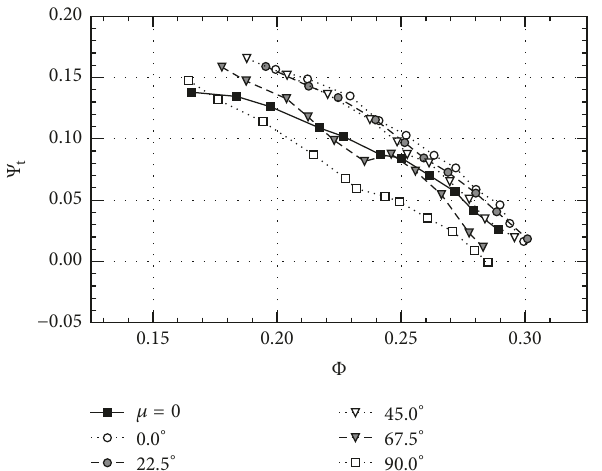
Figure 10: Fan B FD-SI-GG total fan pressure at 𝜇 = 0.25 and different 𝛾 .